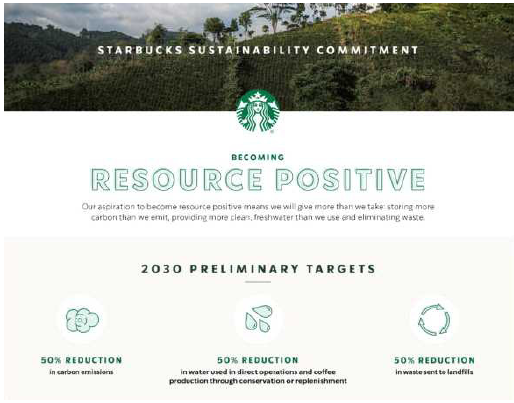
Figure 28. Starbucks Resource Positive Project [80].